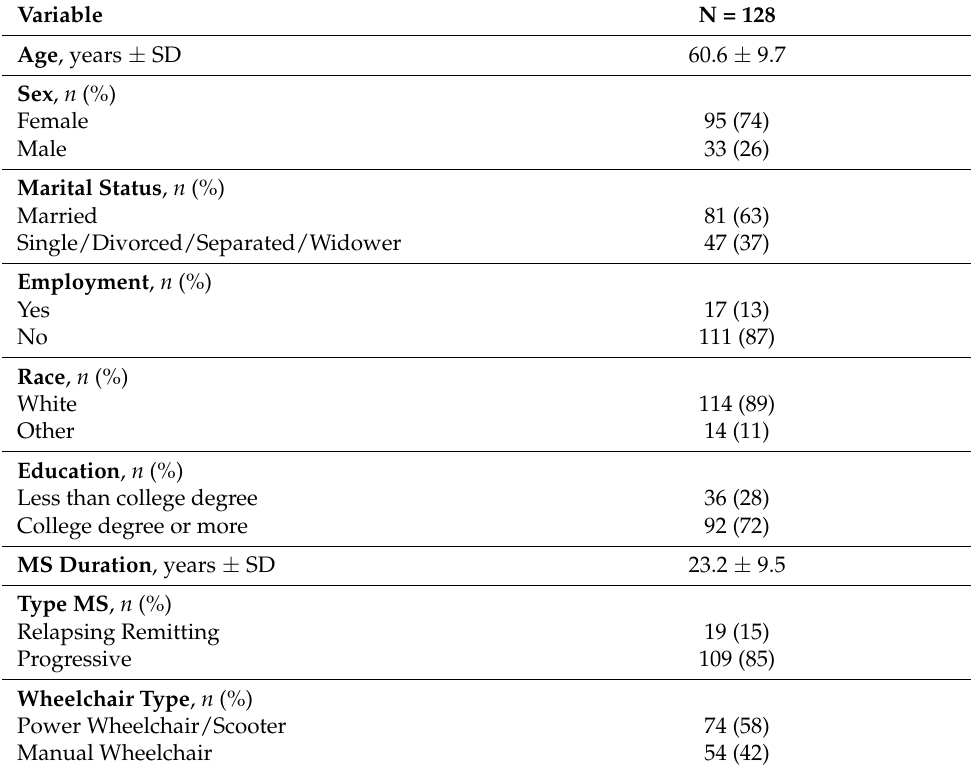
Table 1. Participant demographic and clinical